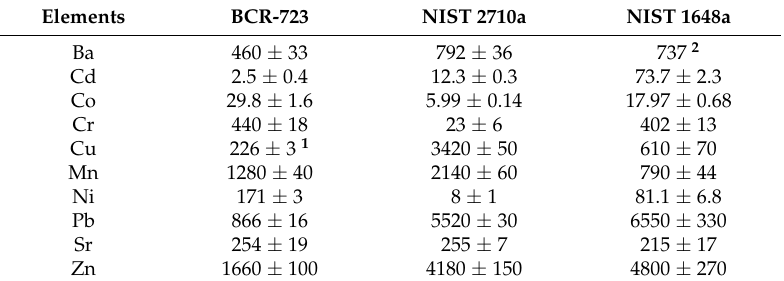
Table 1. Certified values (expressed in mg · kg − 1 ) for selected metals in the three standard